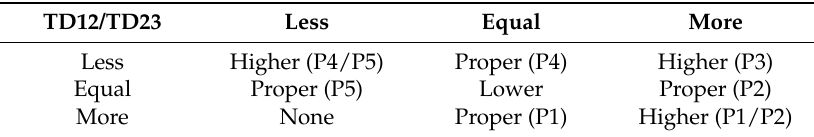
Table 2. Matrix of rules for fuzzy logic system.